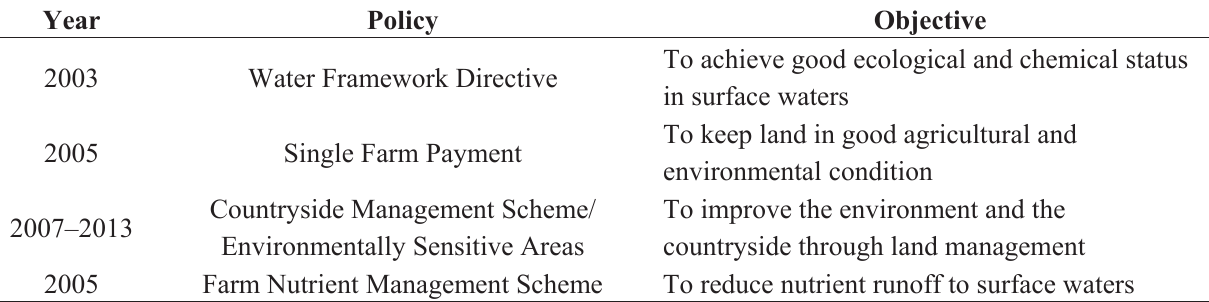
Table 1. Main agri-environmental policies indirectly affecting soil erosion in Northern Ireland and their